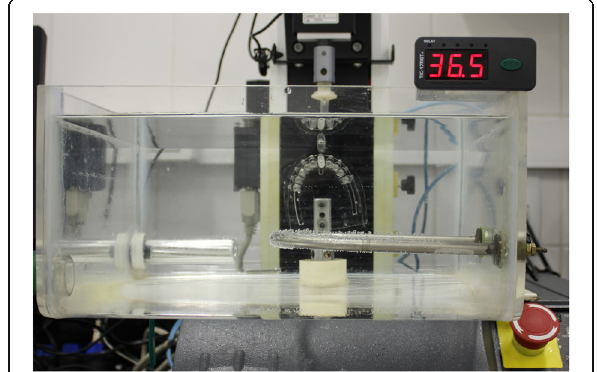
Fig. 3 Acrylic container filled with water containing temperature control system, where the tests were conducted